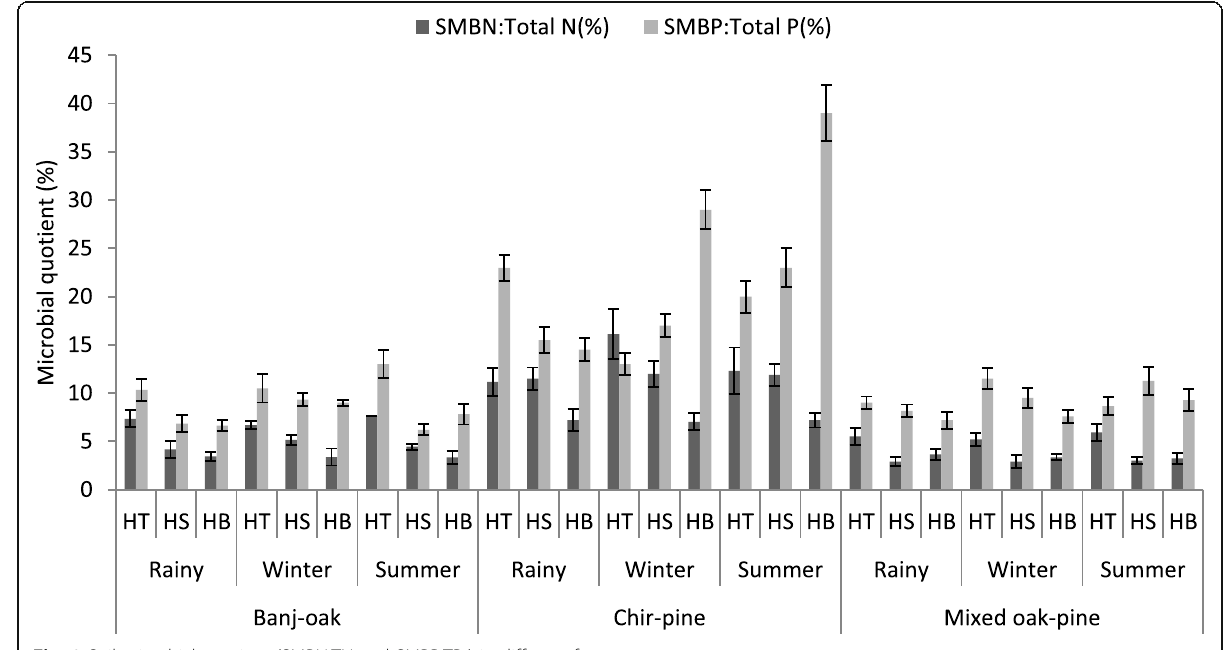
Fig. 2 Soil microbial quotient (SMBN:TN and SMBP:TP ) in different forest